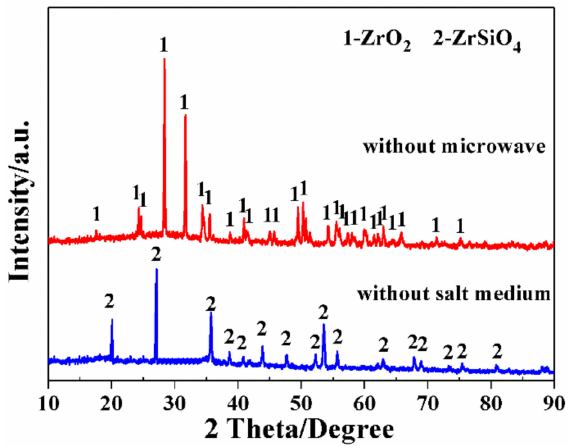
Figure 8. XRD patterns of the samples prepared at 1200 ◦ C/20 min without either microwave heating or a molten-salt medium condition.